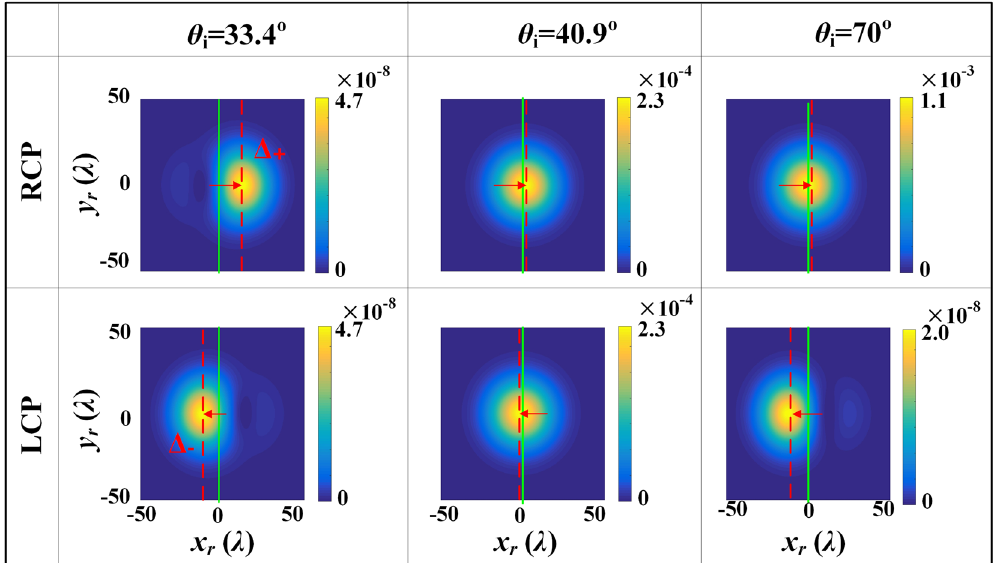
Figure 6. The intensity distributions of the RCP and LCP components of the reflected beam with optimal polarizations incident for three different incident